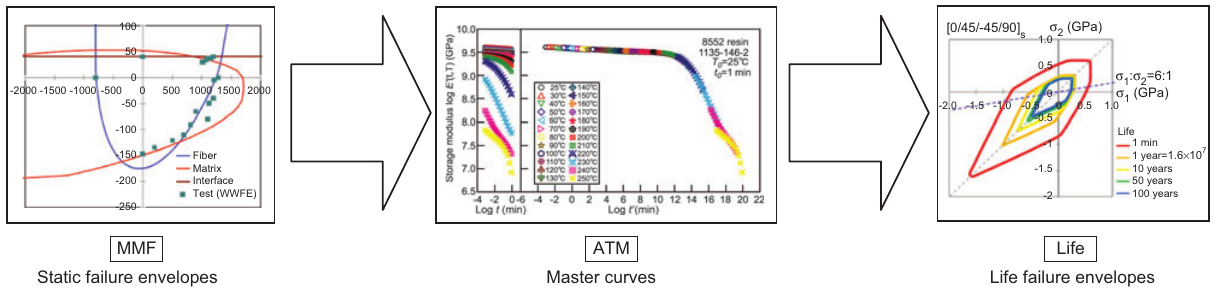
Figure 11 Life estimation summary.